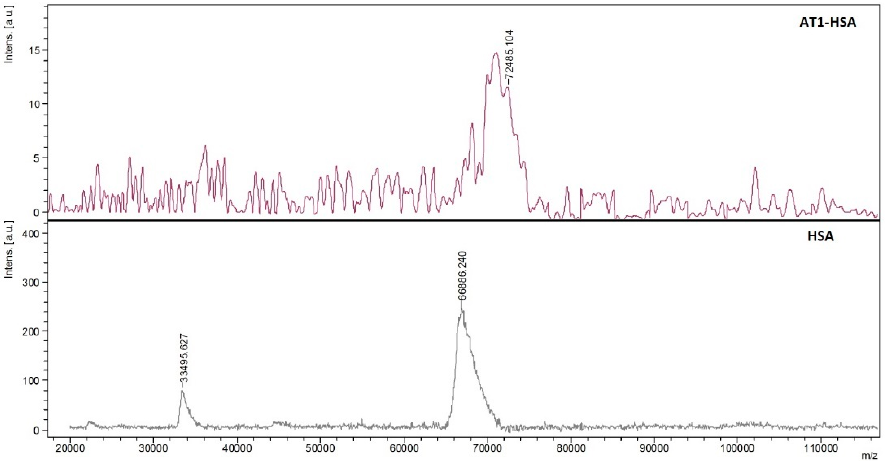
Figure 3. HSA (lower) and AT1-HSA (upper) were analyzed by Matrix-Assisted Laser Desorp- tion/Ionization Time of Flight Mass Spectrometry. The m/z ratio of the AT1-HSA peak was at least 5600 higher than that of the HSA peak, which demonstrated that AT1 was successfully conjugated to the surface of HSA.